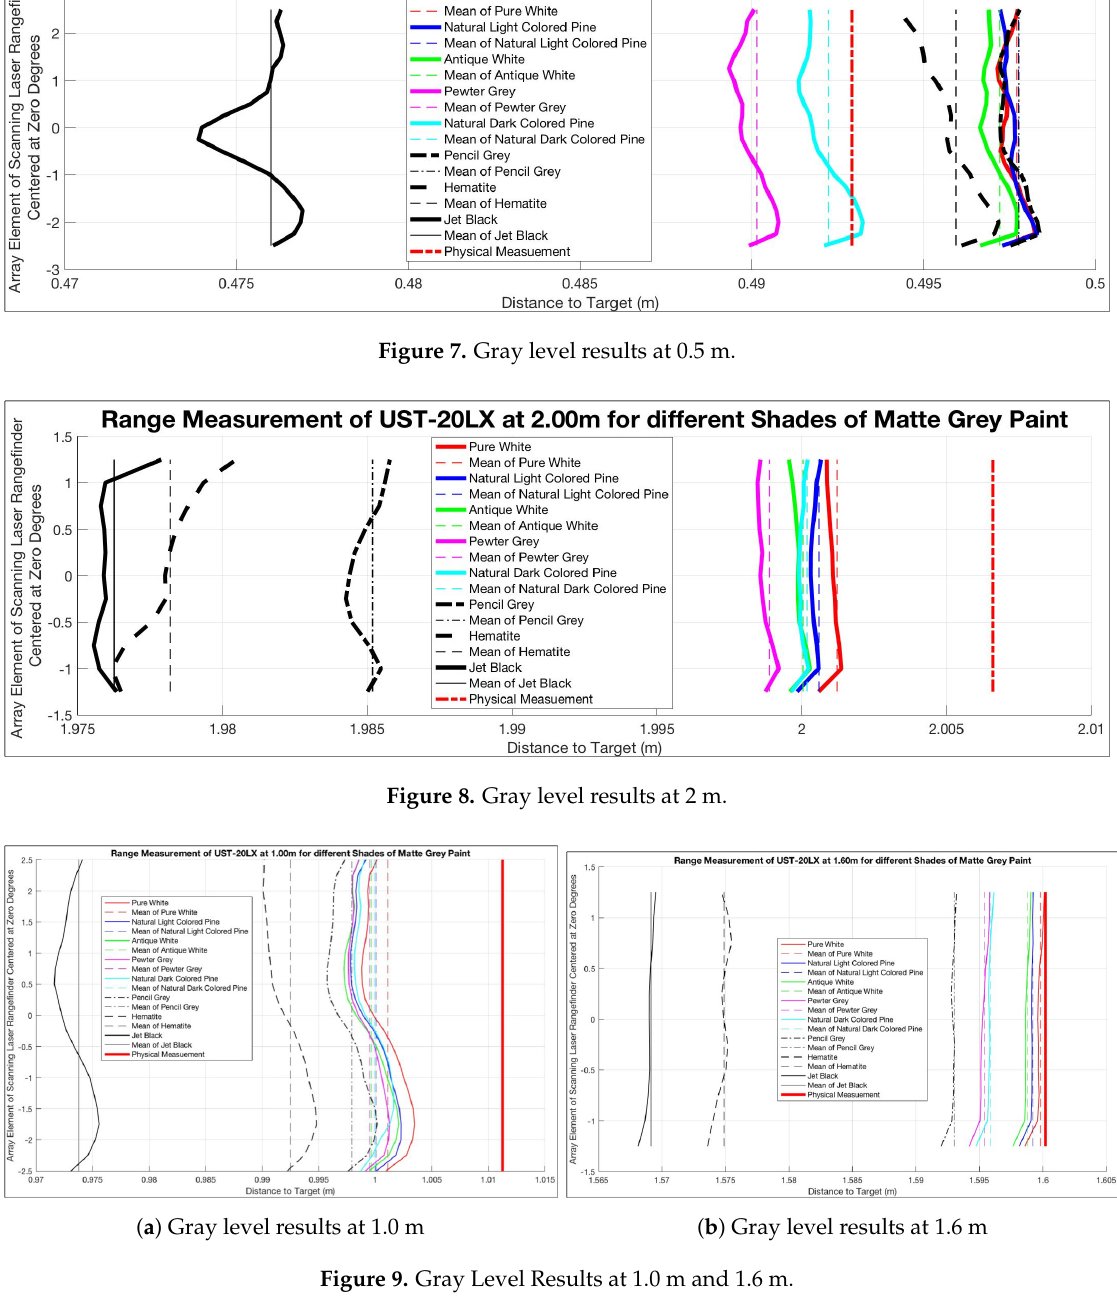
Figure 9. Gray Level Results at 1.0 m and 1.6